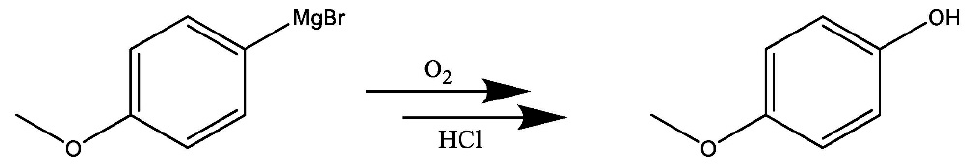
Figure 3. Selective oxidation of 4-Methoxyphenylmagnesium